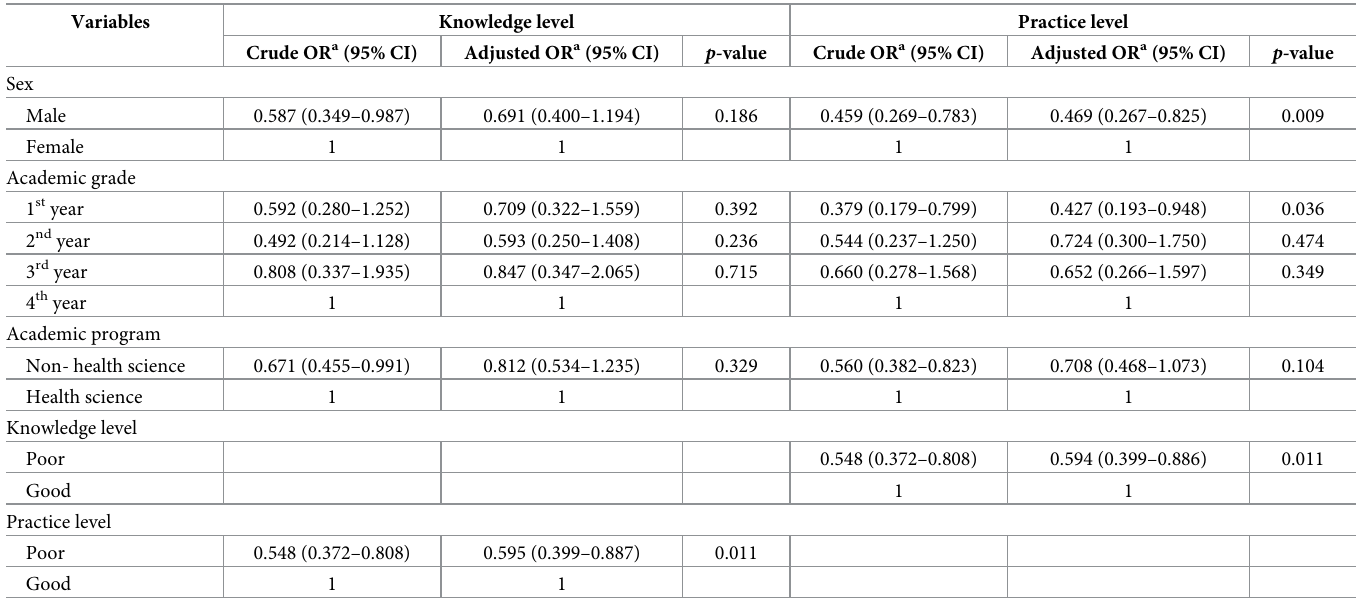
Table 6. Factors associated with facemask disposal knowledge and practices (logistic